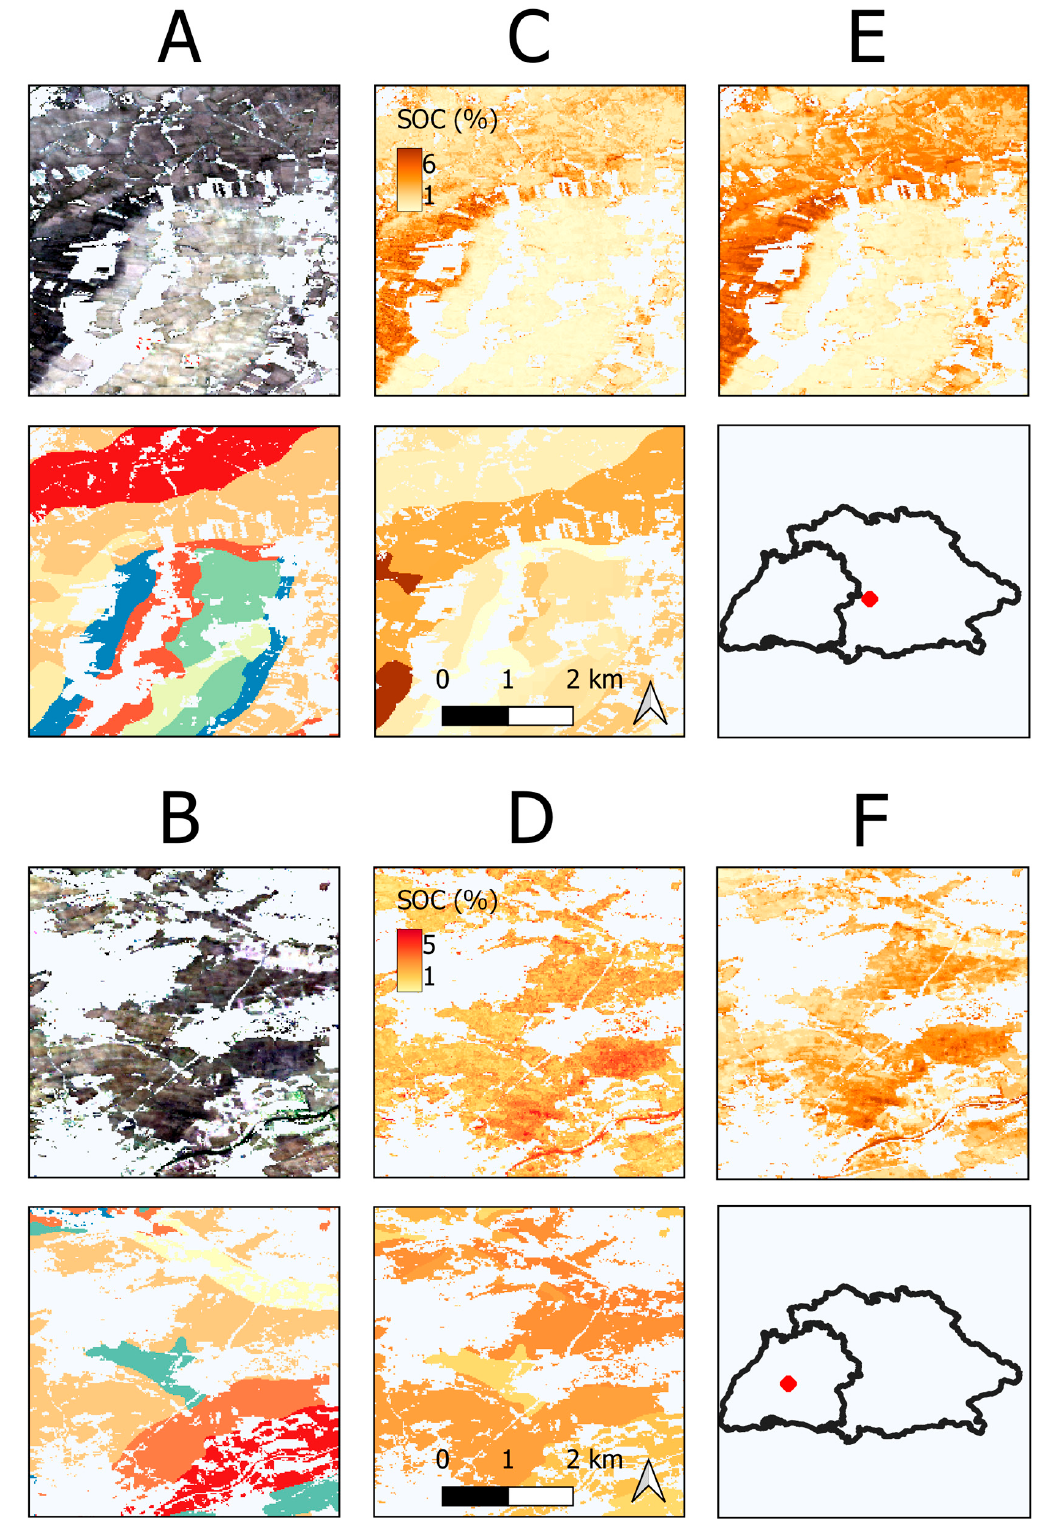
Figure 9. Comparison of the results from different models in BY ( top ) and BW ( bottom ). Examples of the exposed soil composite and soil types as input covariates ( A , B ); Respective SOC prediction for satellite and soil models ( C , D ); SOC predictions of the combined models ( E , F ). Red dots show the locations within the research area.